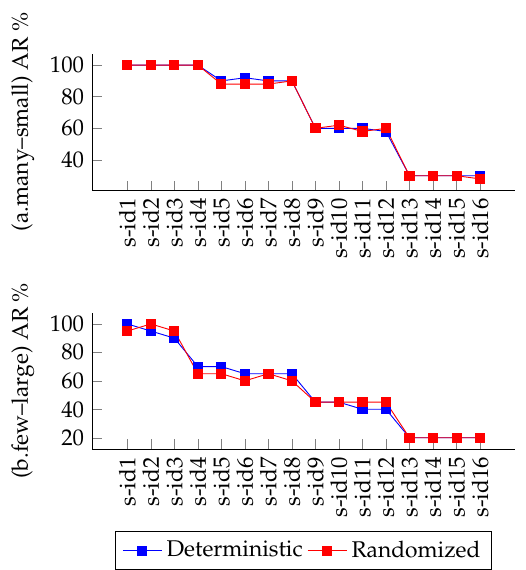
Figure 11. Success of the rounding techniques of